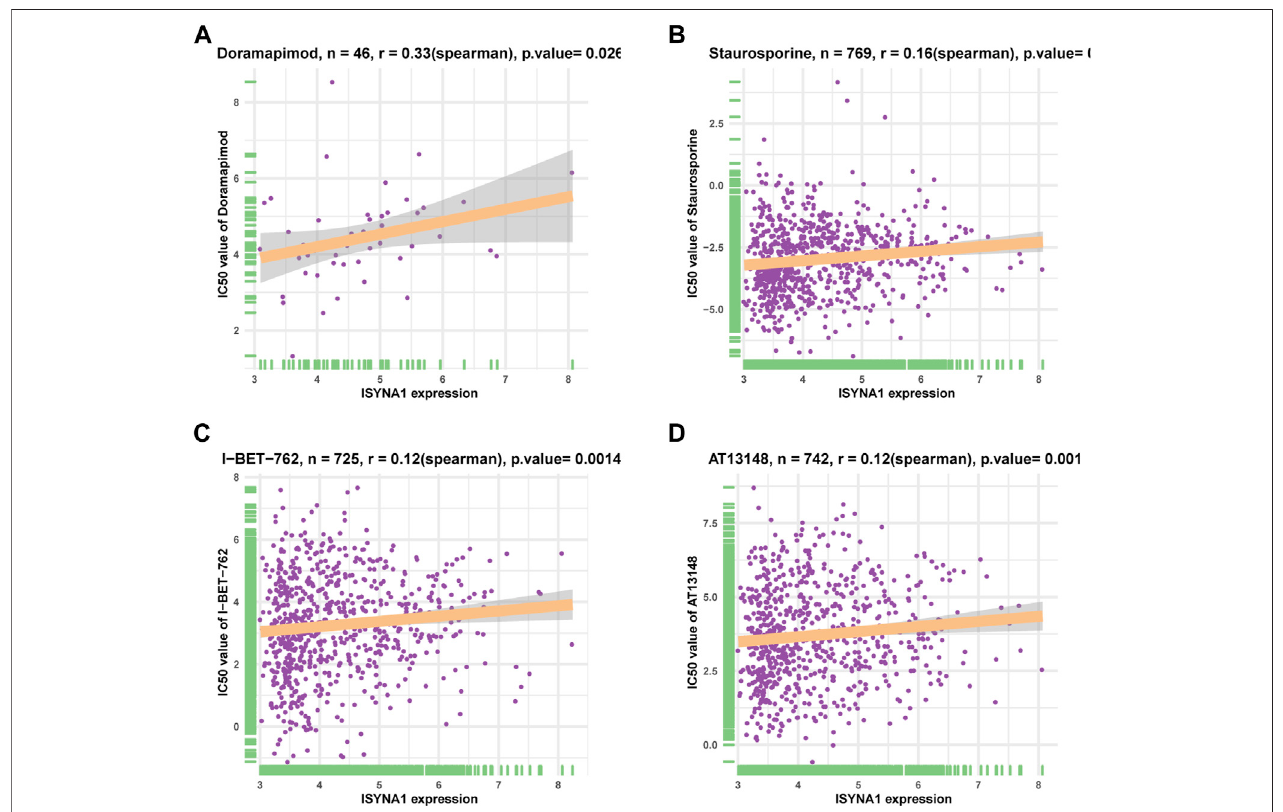
FIGURE 11 | Correlation analysis of ISYNA1 expression and drug response. (A – D) The correlation between ISYNA1 expression and IC50 of indicated anticancer drugs.